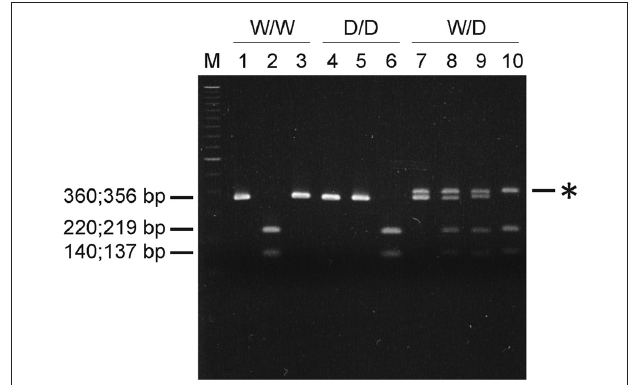
FIGURE 1 | Serotonin transporter (5-HTT) genotyping using restriction endonucleases. PCR was performed with 0.5 µ g genomic DNA from W/W, W/D or D/D chicks and DNA primers 281 and 282. PCR products were digested without (lanes 1, 4 and 7) or with restriction endonucleases Vsp I (lanes 2, 5 and 8) or Mun I (lanes 3, 6 and 9) or with both enzymes (lane 10). Digested DNA fragments were then resolved by electrophoresis on a 2% agarose gel, stained with ethidium bromide and visualized under UV-illumination. Asterisk ( ∗ ) indicates the ∼ 0.4-kb heteroduplex formed from W and D. DNA markers used were the 100-bp ladder (lane